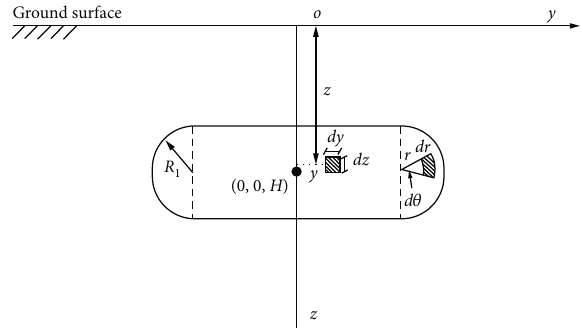
Figure 4: The calculation diagram of additional stress caused by front thrust of